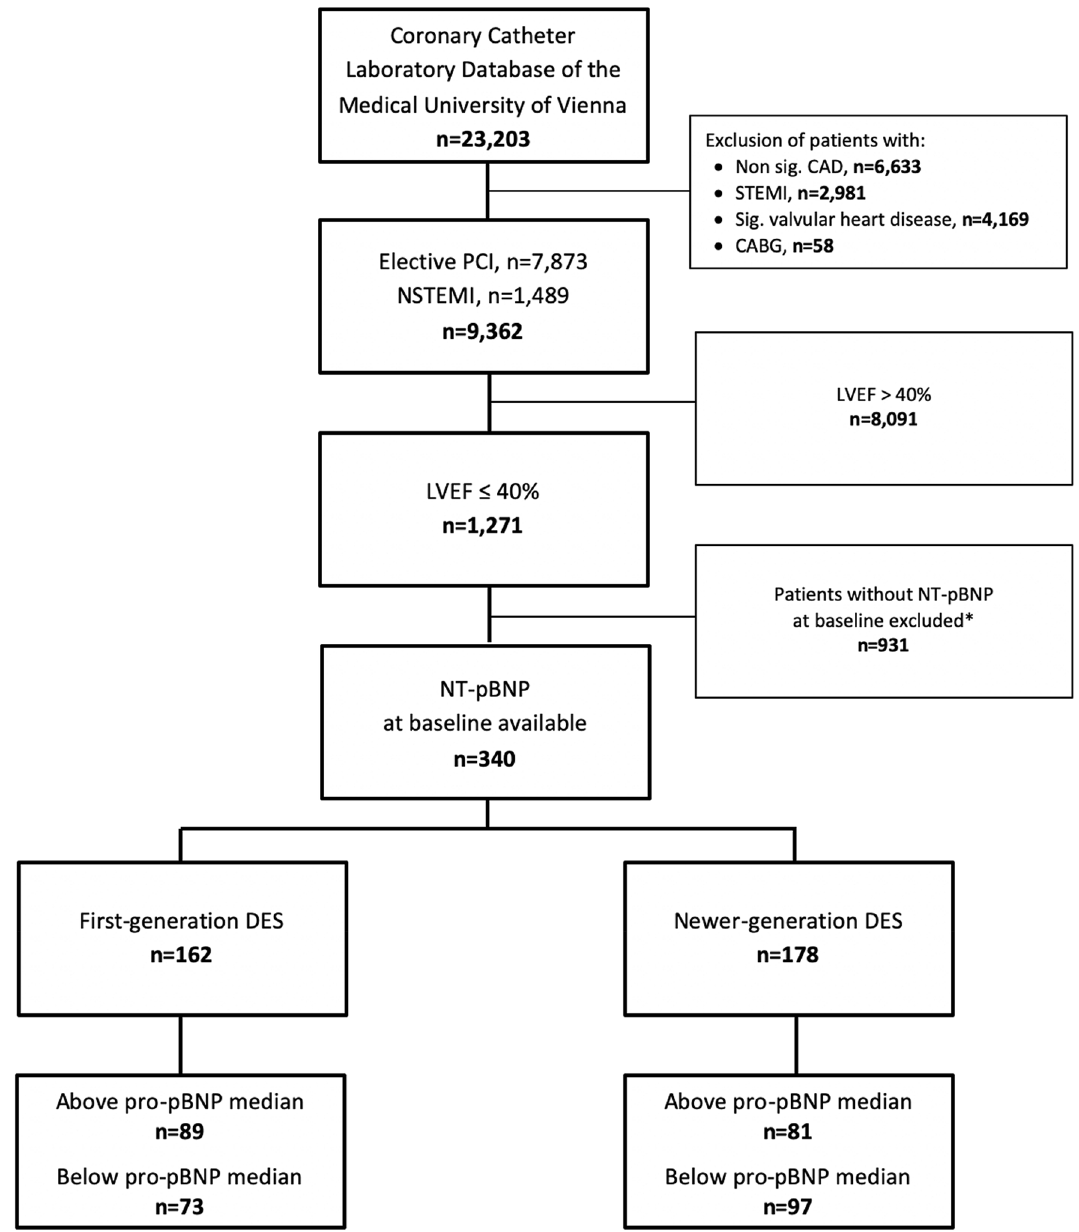
Figure 1. Flow chart. NT-pBNP median (2927 pg/ml, IQR 1282/8524). CABG coronary artery bypass graft, CAD coronary artery disease, DES drug-eluting stent, LVEF left ventricle ejection fraction, NSTEMI non- ST-segment elevation myocardial infarction, NT-proBNP N-terminal proB-type Natriuretic Peptide, PCI percutaneous coronary intervention, STEMI ST-segment elevation myocardial infarction. *NT-proBNP